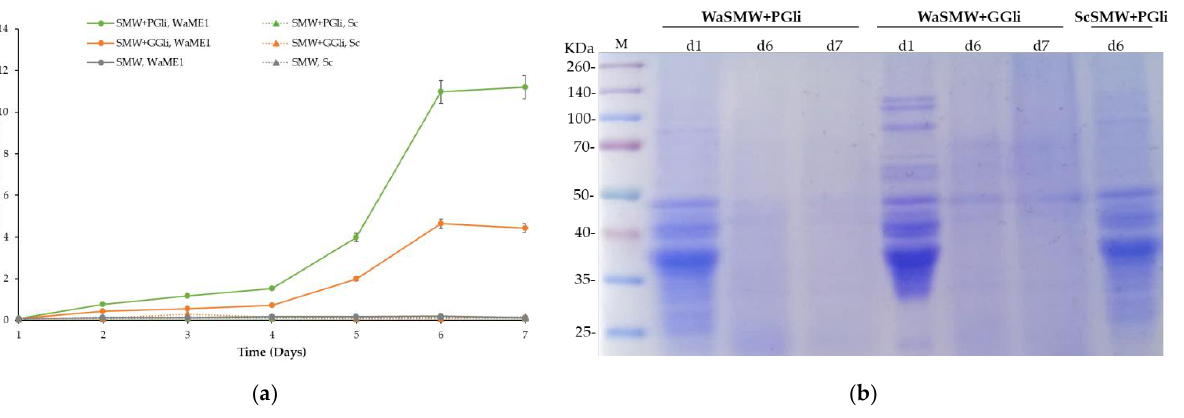
Figure 4. Time-course of W. anomalus ME1 strain growth by daily addition of gliadin proteins. ( a ) Growth of the W. anomalus ME1 strain (WaME1) and the baker’s yeast (Sc) in unfed (SMW) and fed (SMW + PGli or SMW + GGli) media. Synthetic media were fed daily with gliadins (0.5% v / v ) from day 1 to day 6, both included. The points represent the average OD 600 ± standard deviation daily of three independent experiments. ( b ) SDS-PAGE analysis of protein content in fed and unfed cultures. Samples were obtained by adding 10% trichloroacetic acid to 5 mL of culture after removing yeast cells by centrifugation. The protein pellet was resuspended in 25 µL of loading buffer, and half the sample (12.5 µL) was loaded onto the gel. The analysis of the samples taken from W. anomalus (Wa) cultures on days 1, 6, and 7 (d1, d6, d7) and from S. cerevisiae (Sc) cultures on day 6 (d6), just before adding the daily dose of gliadin proteins, is shown. M, protein mixture (25 – 260 kDa) was used as the molecular weight marker.